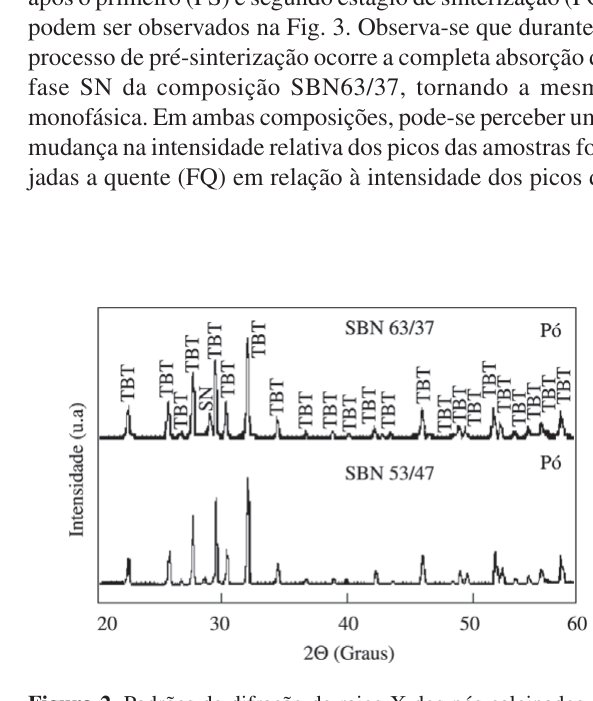
Figura 2. Padrões de difração de raios-X dos pós calcinados de SBN. TBT- fase SBN com estrutura tungstênio-bronze e simetria tetragonal; SN- fase de niobato de